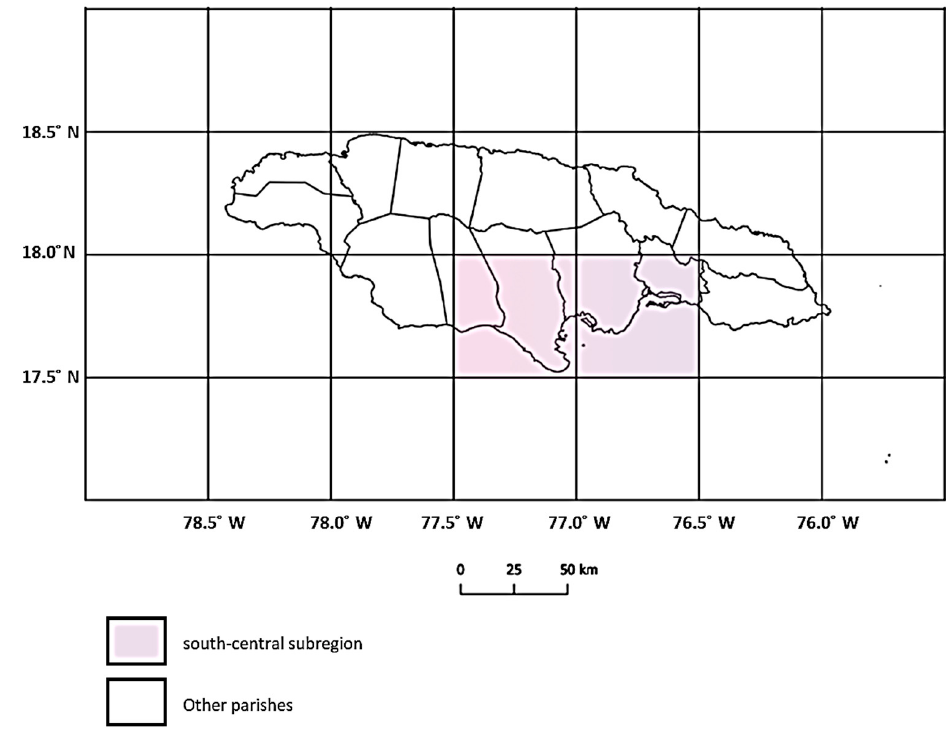
Figure 2. Map of Jamaica showing ERA5 Reanalysis Grids with highlighted subregion.